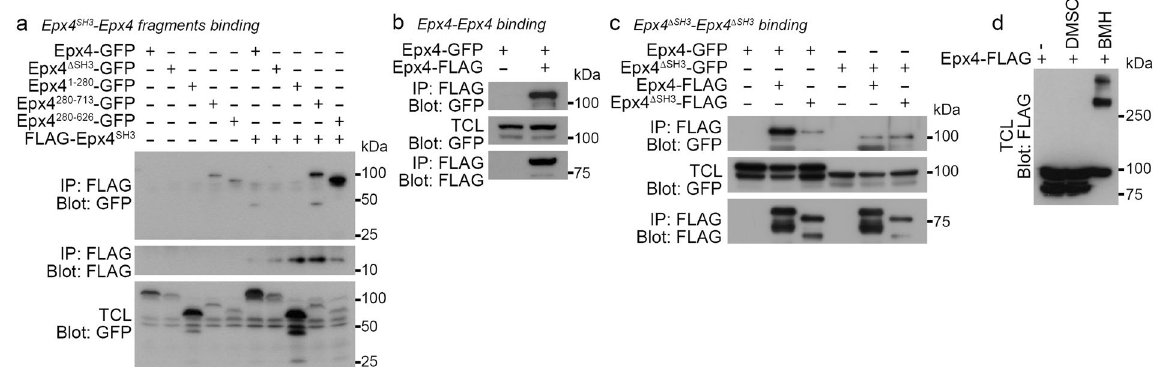
Figure 2. The SH3 domain mediates homotypic interaction of Ephexin4. ( a ) 293 T cells were transfected with the indicated plasmids. Two days after transfection, the SH3 domain of Ephexin4 was immunoprecipitated with anti-FLAG antibody and the co-immunoprecipitated proteins were detected with anti-GFP antibody. ( b ) GFP- and FLAG-tagged Ephexin4 were expressed in 293 T cells and then lysed. Ephexin4-FLAG was immunoprecipitated with anti-FLAG antibody, and co-immunoprecipitated proteins were detected with anti- GFP antibody. ( c ) 293 T cell were transfected with the indicated plasmids, lysed and immumoprecipitated with anti-FLAG antibody. Co-immunoprecipitated proteins were detected with anti-GFP antibody. ( d ) 293 T cells were transfected with Ephexin4-FLAG. Two days after transfection, the cells were incubated in the presence or absence of 0.25 mM BMH at room temperature for 1 h. Ephexin4-FLAG was detected by immunoblotting with anti-FLAG antibody. Immunoblots are cropped for conciseness and their full-length blots are shown in Supplementary S4. Epx4, Ephexin4; TCL, total cell lysates.